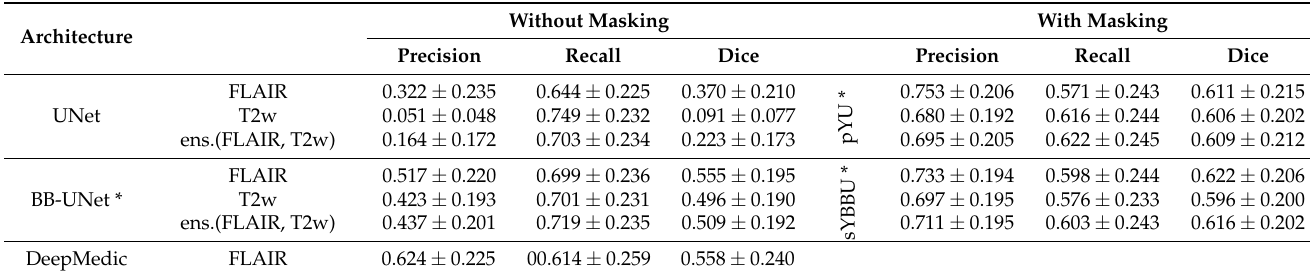
Table 8. Segmentation results on 62 sessions from DIPG, using FLAIR detection masks. Results present the mean ± standard